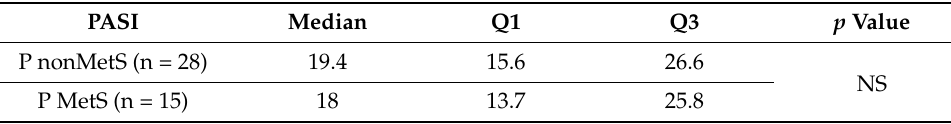
Table 3. PASI score of all patients.